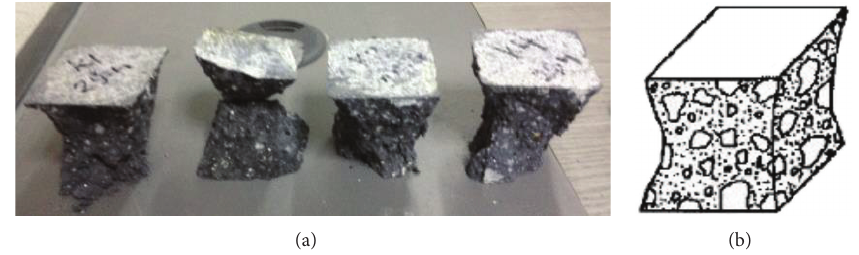
Figure 7: (a) Failure mode of cubes. (b) Satisfactory failures of BSEN